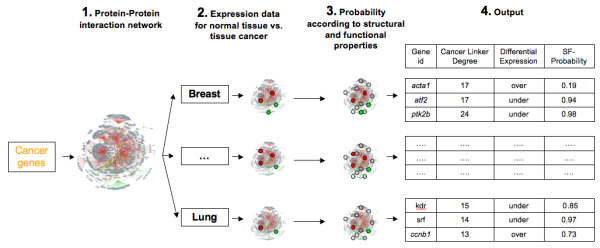
Procedure followed to predict cancer gene candidates. First, a cancer protein interaction network is built from the list of known cancer genes. Second, expression data from different cancer types is mapped onto the network. Third, probabilities of being a cancer gene based on structural, functional and evolutionary properties are retrieved for proteins in the network. Fourth, cancer genes are predicted based on the thresholds provided by the user for each type of data.